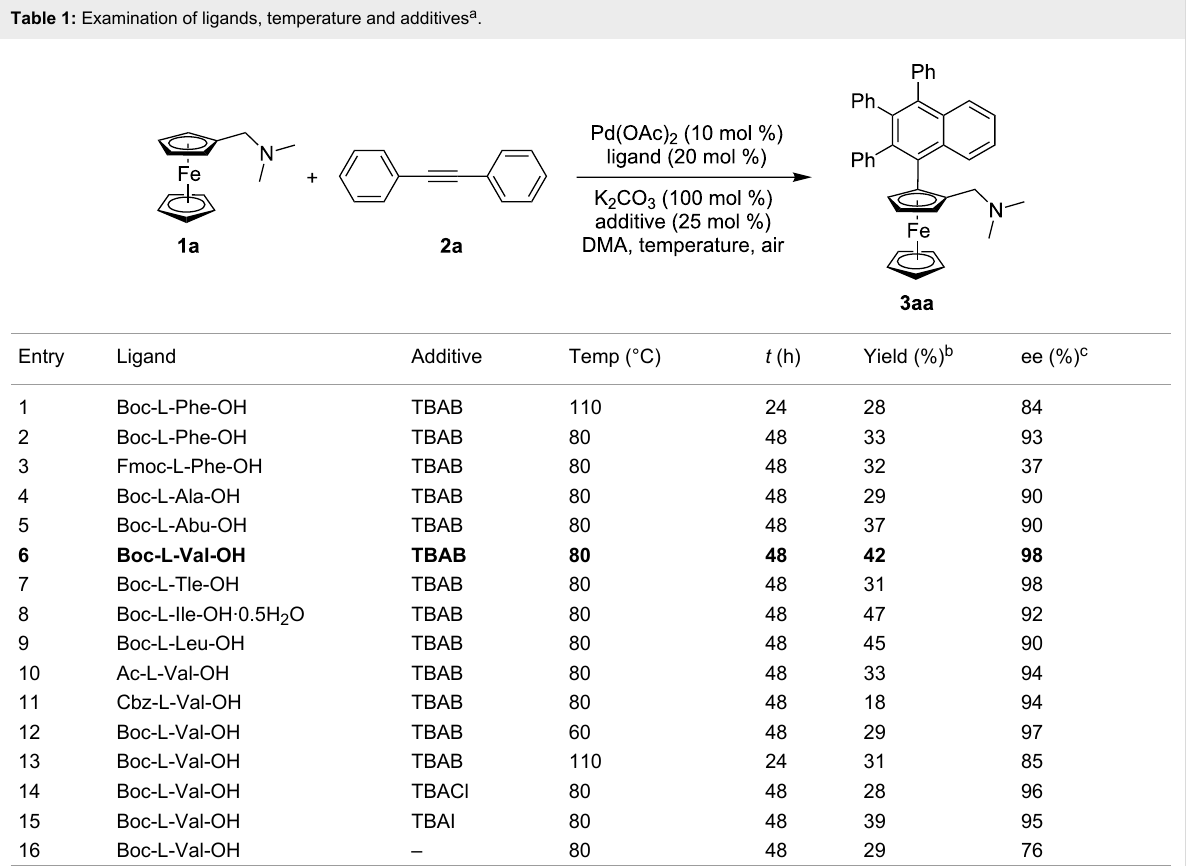
Table 1: Examination of ligands, temperature and additives a .